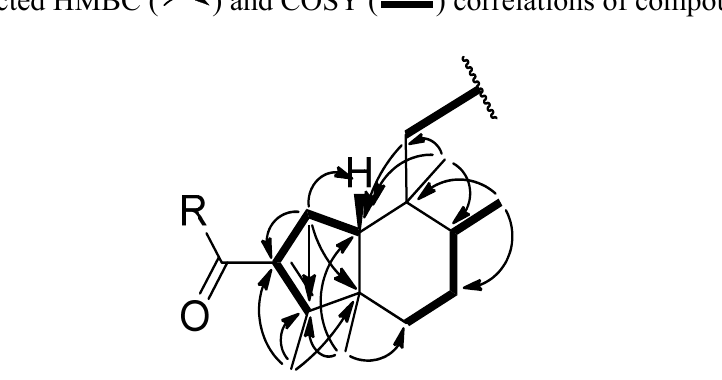
Figure 2. Selected HMBC ( ) and COSY ( ) correlations of compounds 1 – 2 .